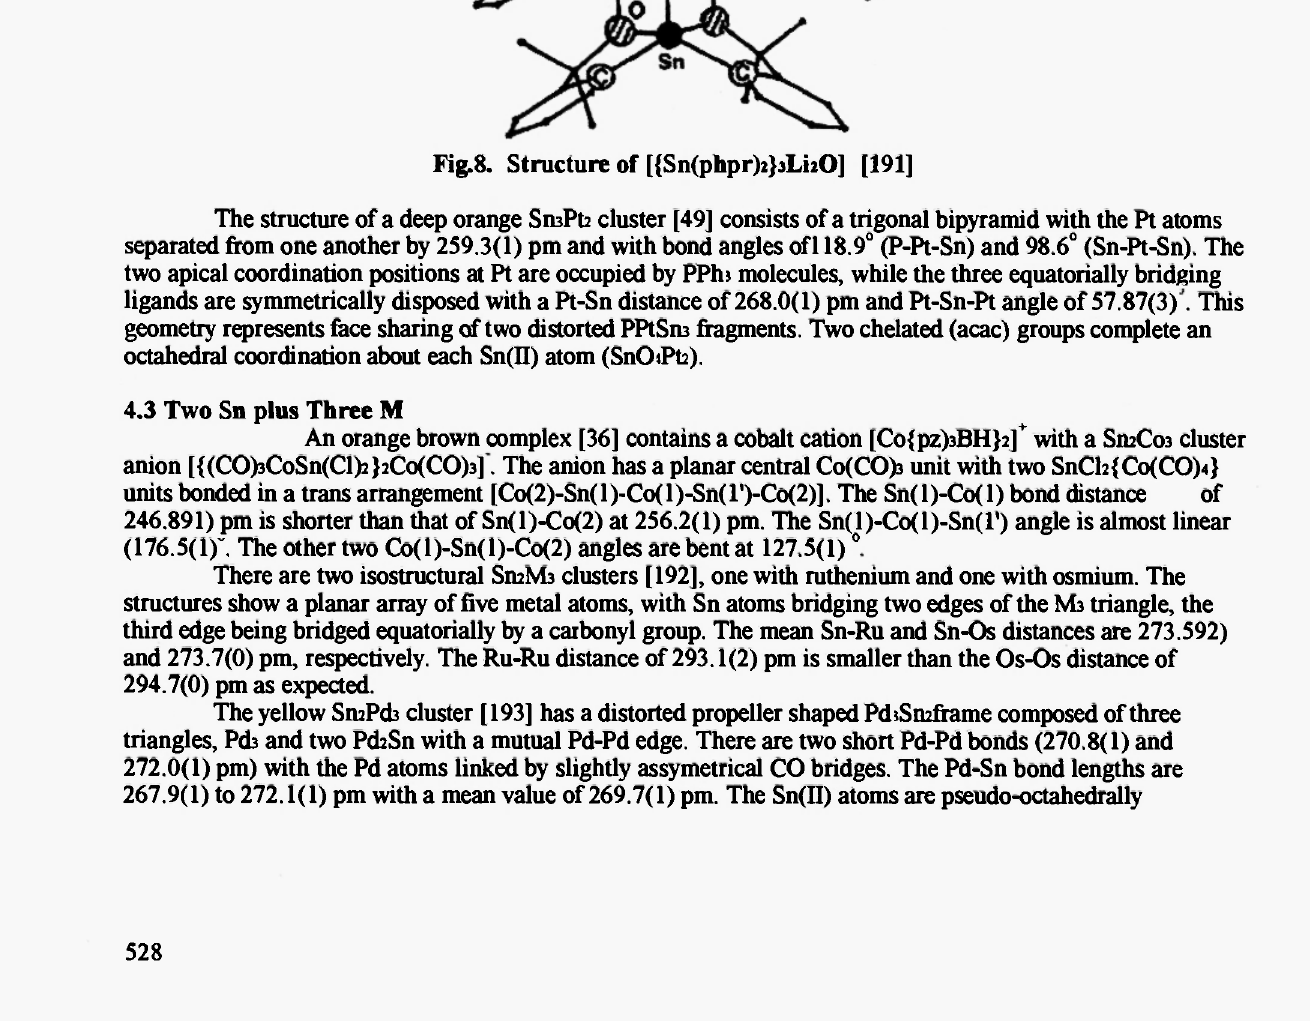
Fig .8. Structure of [{Sn(phpr)2}